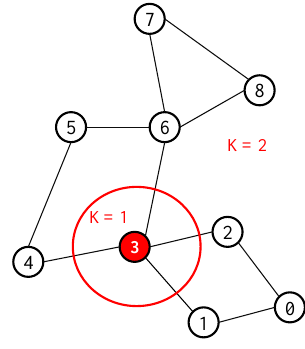
Figure 2 . Two neighborhood depth of target room 3